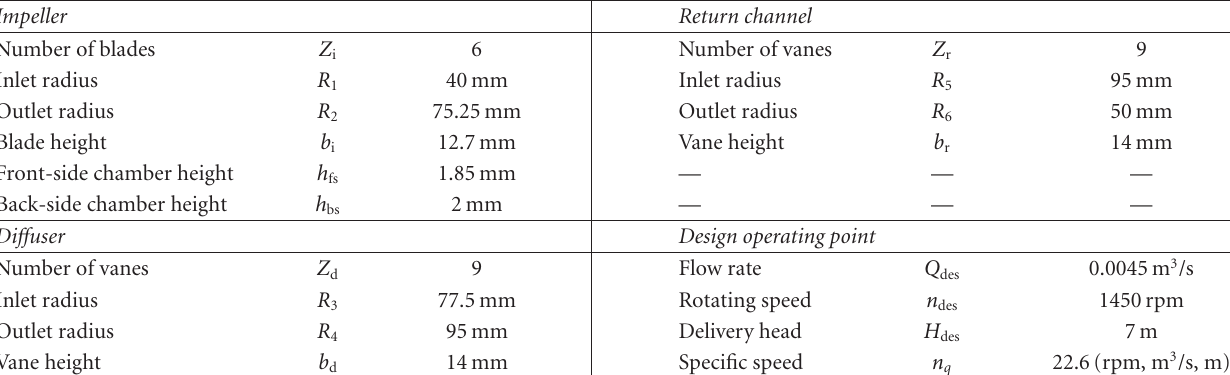
Table 1: Specifications of the pump stage.